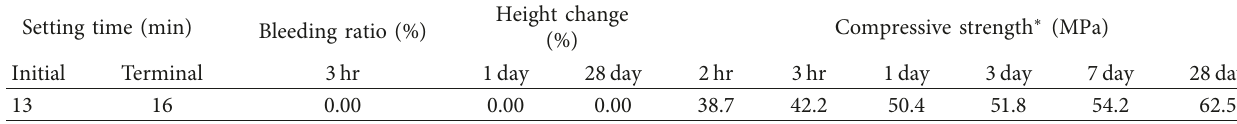
Table 3: Ultra-rapid-hardening cement quality test results.